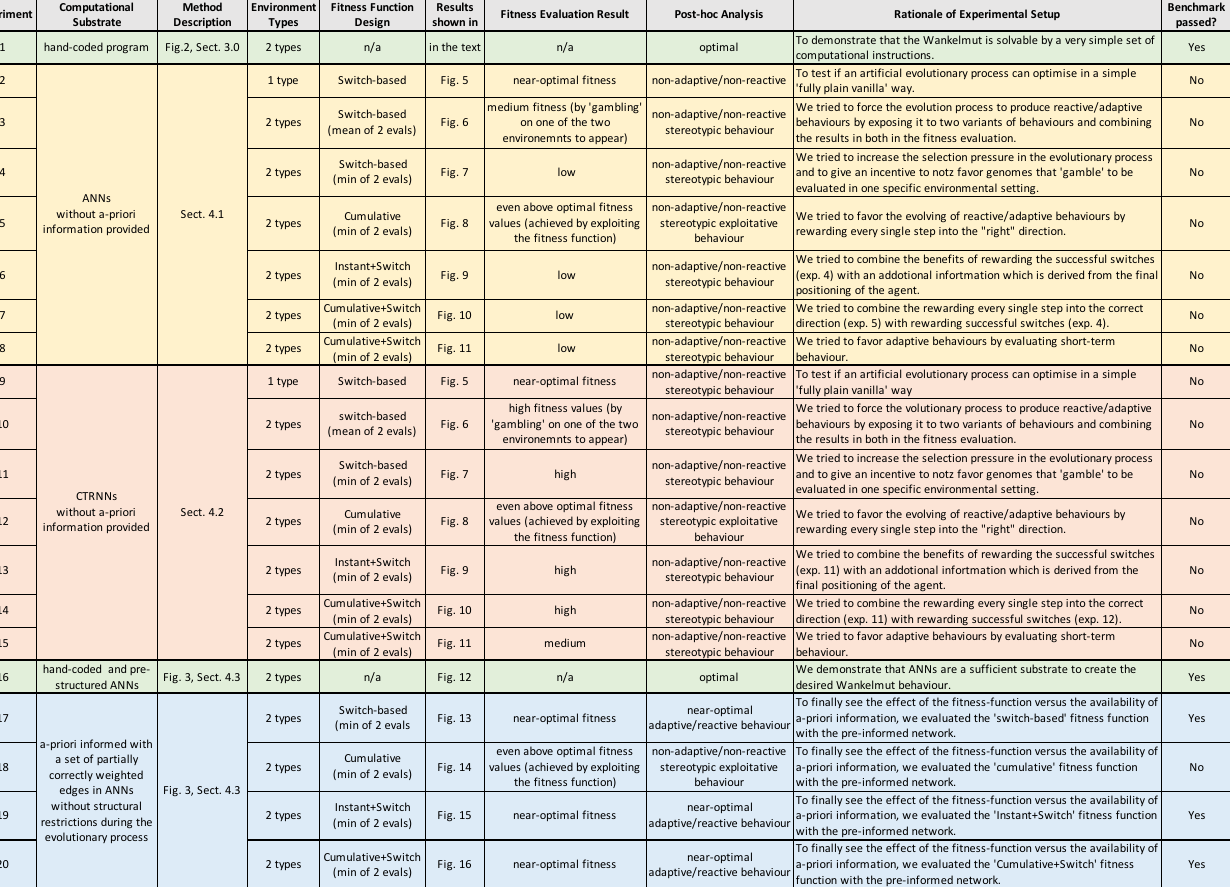
non-adaptive/non-reactive stereotypic exploitative behaviour